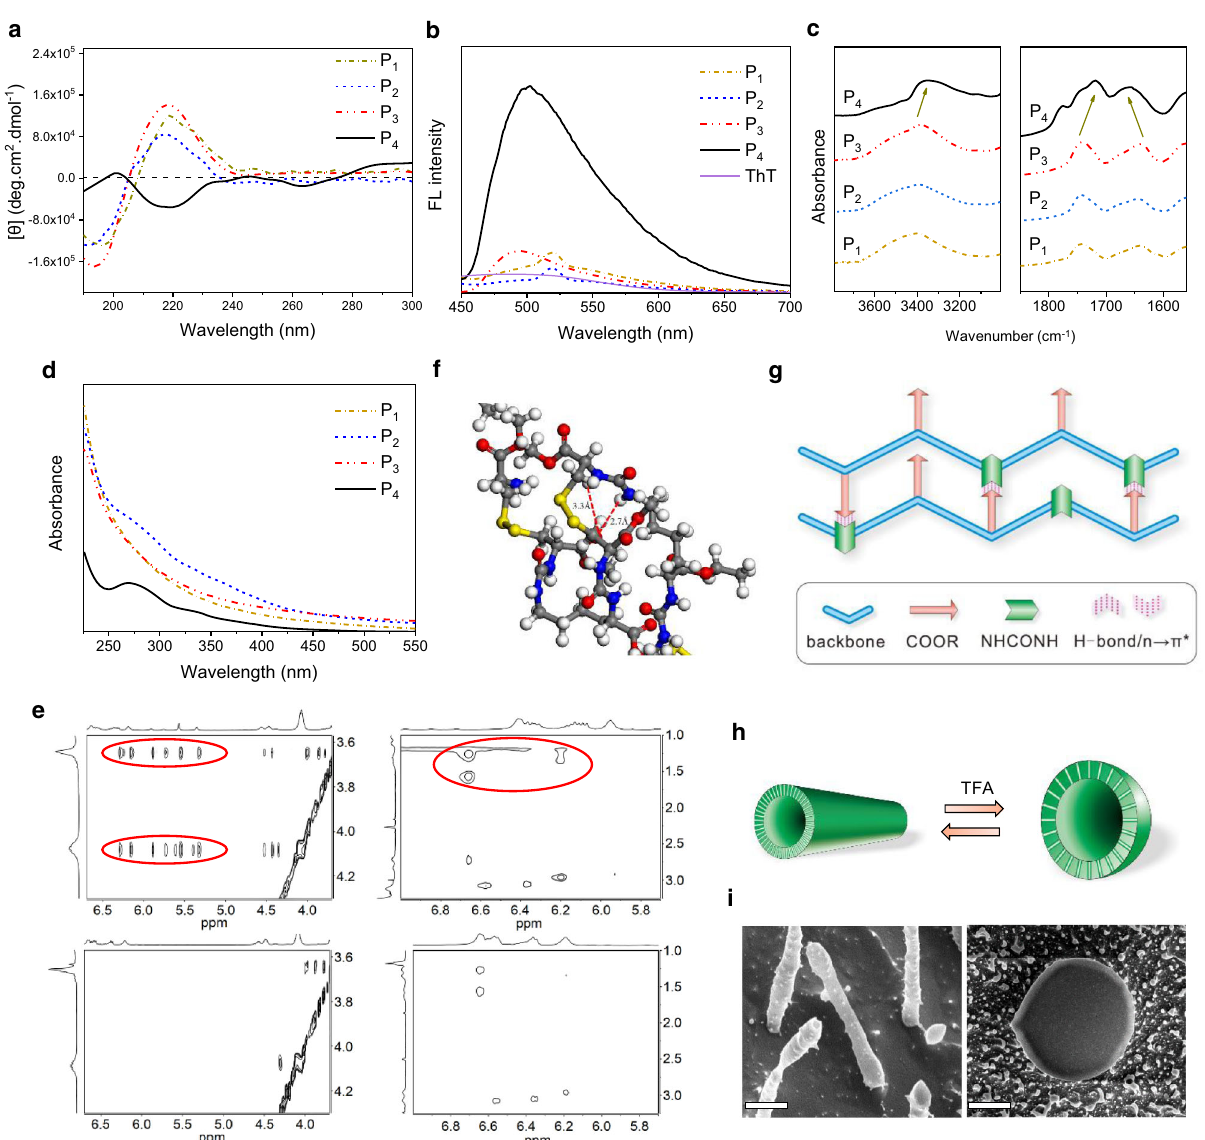
Fig. 2 | Conformation-assisted metamorphosis. a CD spectra of PU assemblies. b Fluorescence emission spectra ( λ ex =440nm) of PU assemblies incubated with 100 μ M of ThT. c FTIR spectra of PUs in the NH (left) and C=O (right) stretching regions. d UV – vis spectra of PU assemblies. e 1 H − 1 H NOESY spectra of P 4 (upper panel)andP 3 (lowerpanel). f Representativemoleculardynamicssimulationimages